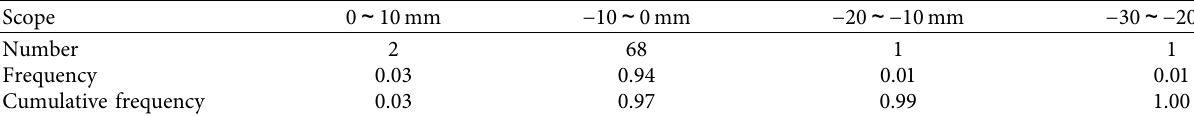
Figure 12: Variation curve of lateral displacement of monitored sections at Junfeng Road Station. Table 10: Statistics of surface settlement data.